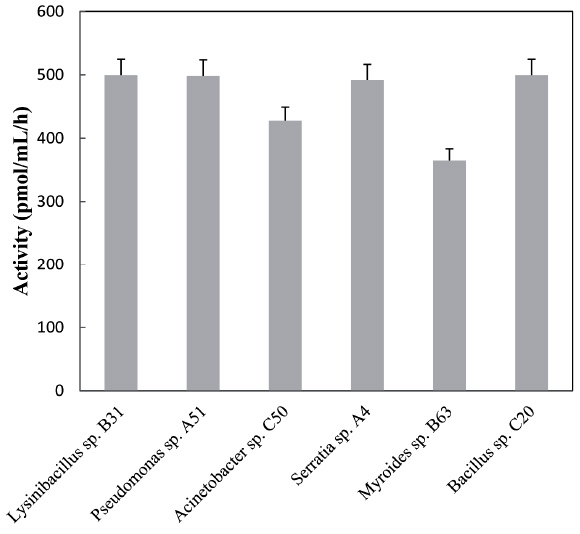
Figure 4. AHL inactivation analysis of the representative phyllosphere isolates. The activities are expressed in picomoles of 3OC6-HSL inactivated per hour per volume of bacterial culture. Bars indicate standard deviation values of the